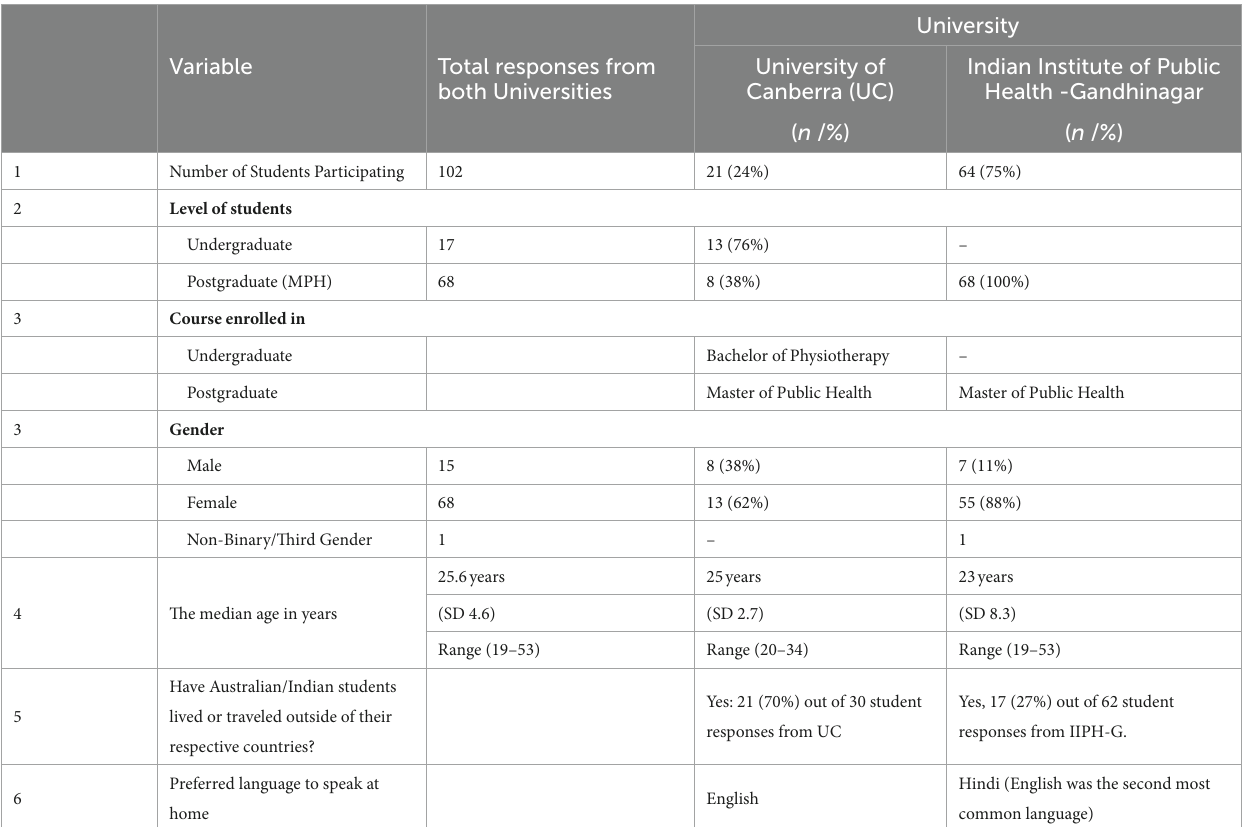
TABLE 1 Basic sociodemographic details of participating students overall and from each